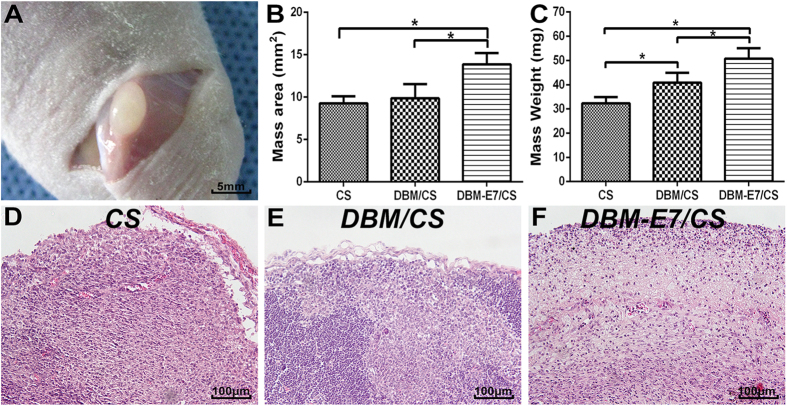
General evaluation of the neocartilaginous tissue of the three groups.(A) Gross observation of hyaline cartilage-like tissue. (B) Mass area analysis of regenerated neotissue (n = 5, *p < 0.05). (C) Mass weight of tissue regenerated by the three scaffolds after harvesting (n = 5, *p < 0.05). (D–F) H&E staining of the neo-tissue generated by CS, DBM/CS, and DBM-E7/CS scaffolds.